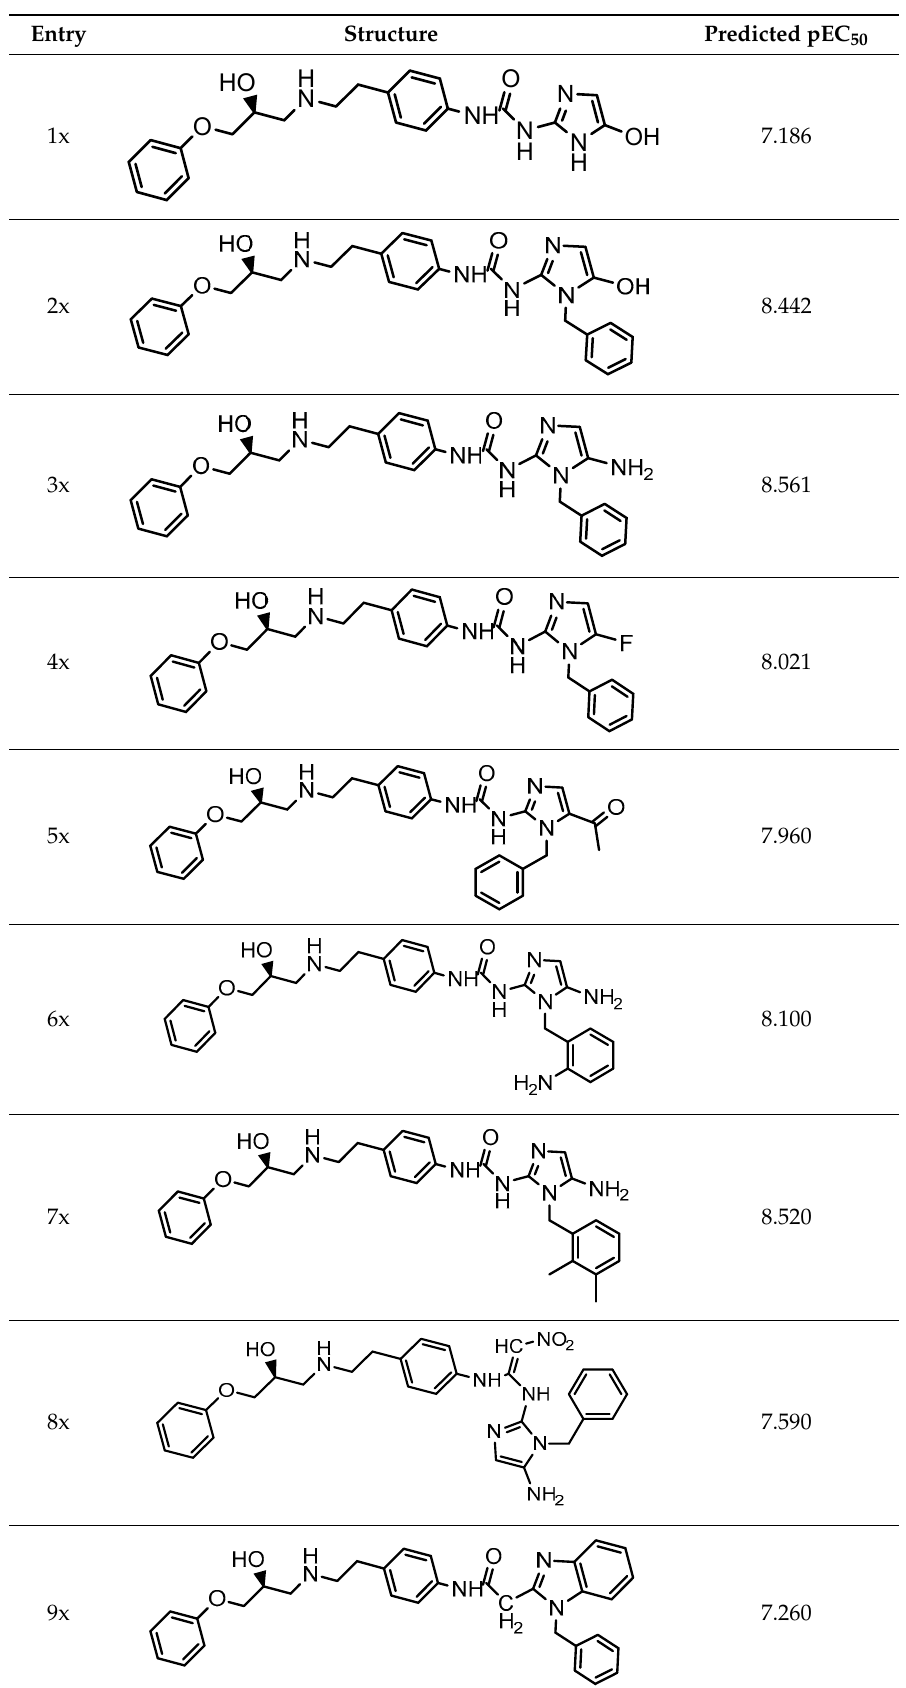
Figure 4. CoMSIA electrostatic ( A , B ); steric ( C , D ); hydrophobic ( E , F ); donor ( G , H ) and acceptor ( I , J ) contour maps around compounds 16 ( left ) and 21 ( right ), the most active and less active of the series respectively. The colors in A – D have the same meaning as in the CoMFA contour maps. Hydrophobic favored areas are in yellow and unfavorable areas in grey ( E , F ). Donor and acceptor favored areas are in cyan and magenta respectively, and donor and acceptor unfavorable areas are in purple and red, respectively ( G – J ). Table 5. The proposed structures of new molecules and their predicted pEC 50 values using the best model.